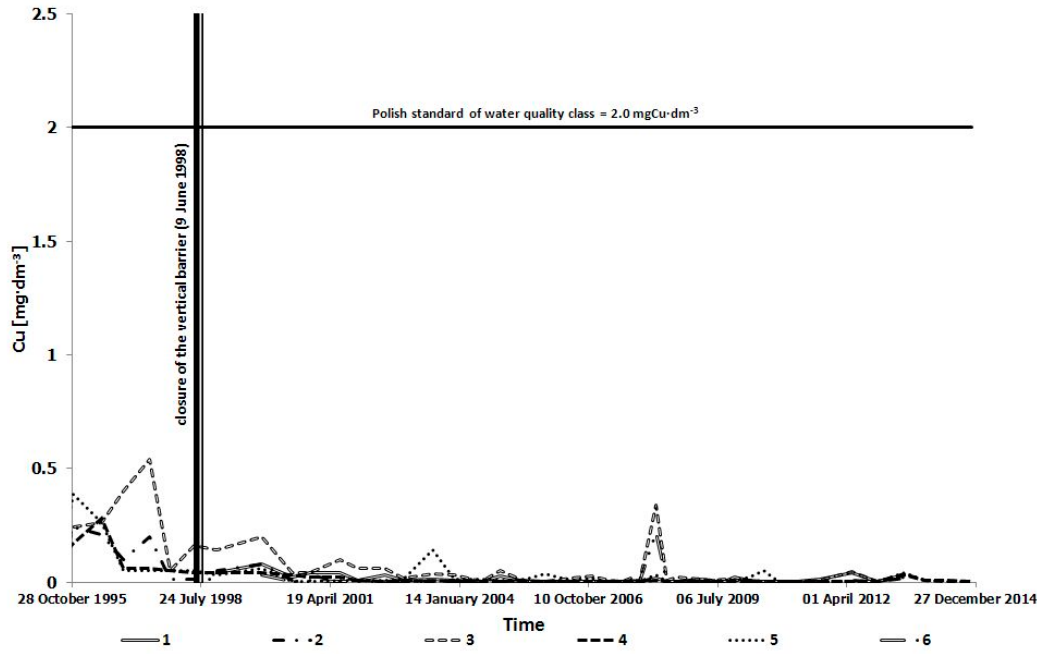
Figure 6. Changes of copper concentration in groundwater on MSW Łubna Landfill surroundings during monitoring period 1994–2014.